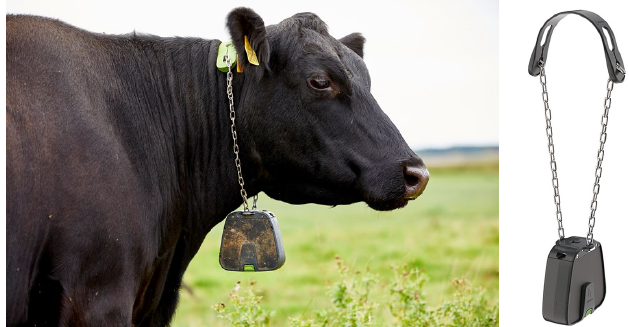
Figure A1. Nofence collar (Photo: J.